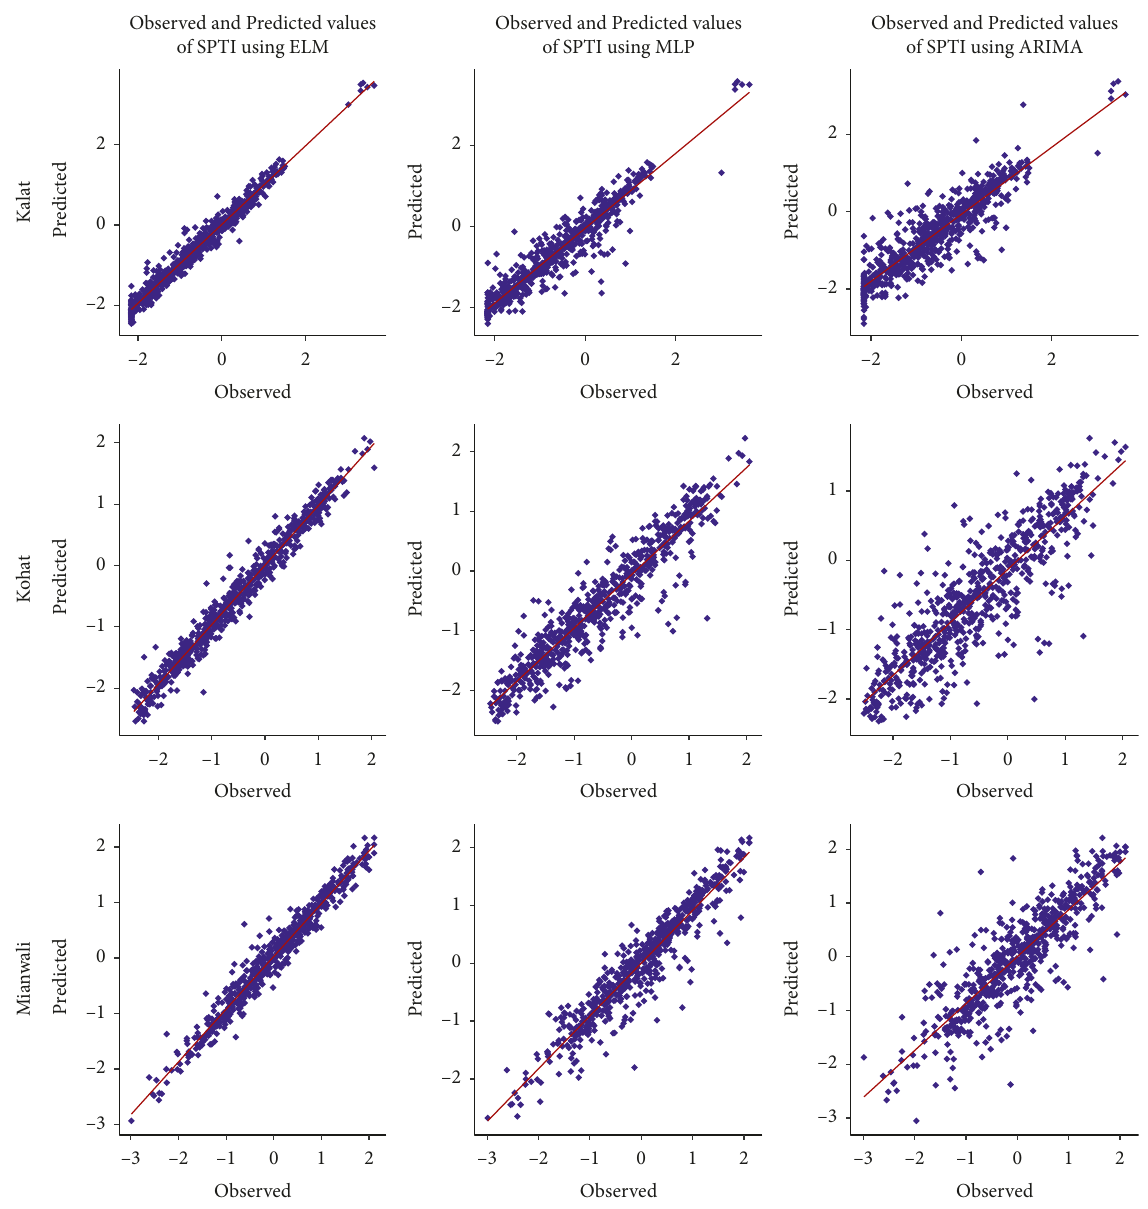
Figure 9: Scatter plots of the observed and predicted values of SPTI using ELM, MLP, and ARIMA at Kalat, Kohat, and Mianwali stations for the training